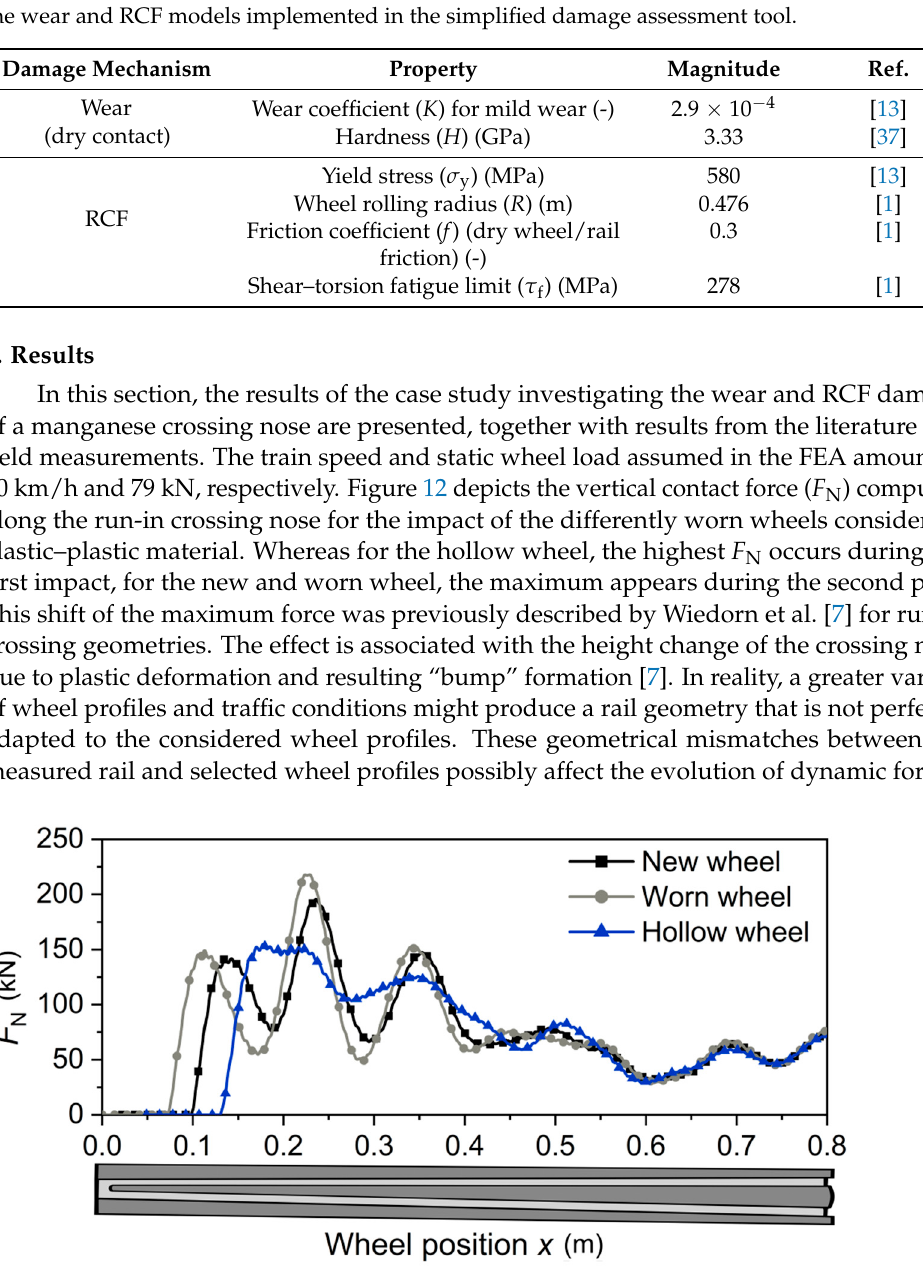
Figure 12. Vertical contact force ( F N ) computed in the FEA for the impact of a new, worn and hollow wheel on the run-in crossing nose with the measured rail profile after 11.9 MGT.